Question: Summarize what this figure shows in one sentence.
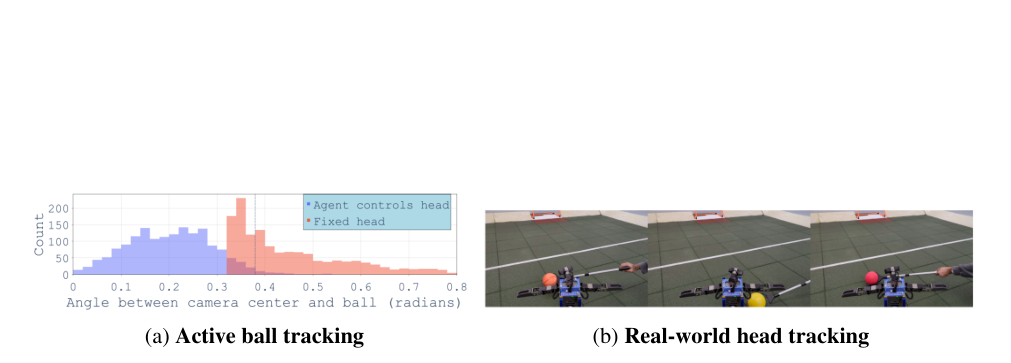
Answer: (Left): Histograms of the angular distance between the center of the camera view and the ground-truth ball location, over 16 episodes. The vertical line indicates the approximate size of the camera’s field of view. In the red control group, the camera is fixed facing forward while in the blue trajectories the learned policy is allowed to only move the head. (Right): We freeze all joints except head pan and tilt to demonstrate the learned use of controlling the head camera for active perception. Ball color randomization ensures the agent is able to track balls with a range of colors.